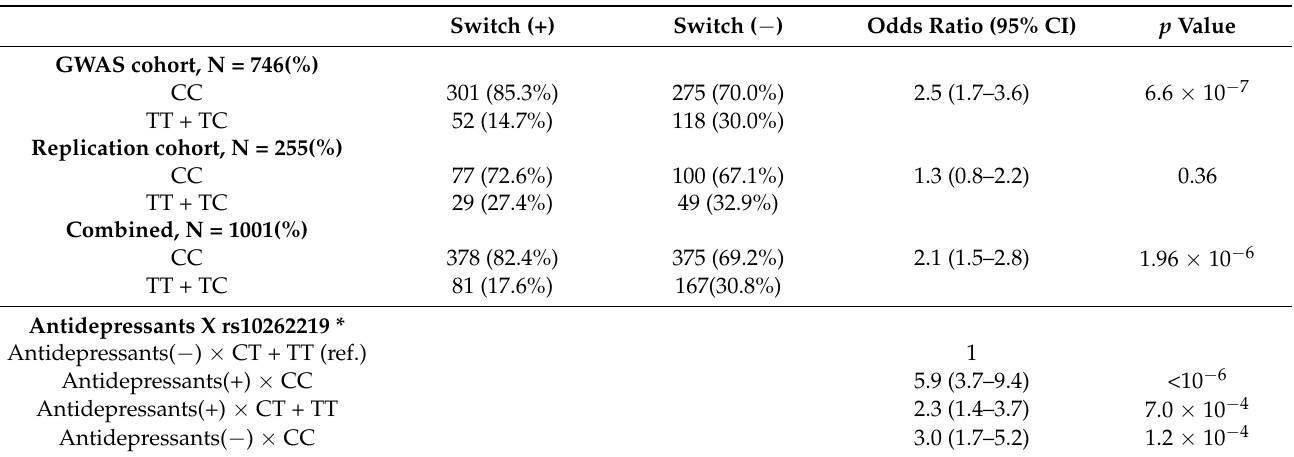
Table 2. Effects of antidepressants treatment and rs10262219 genotypes on manic switch after bipolar